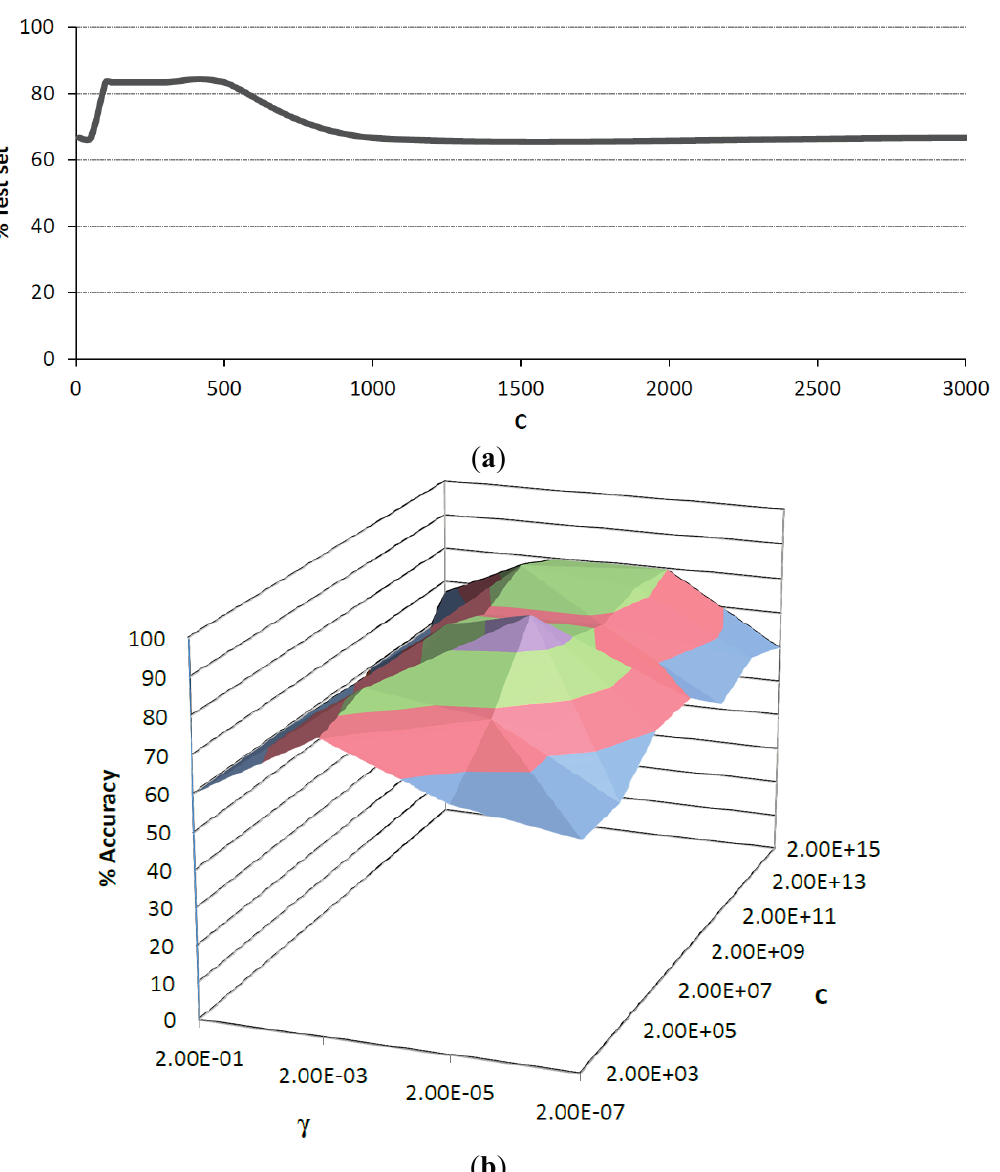
Figure 5. ( a ) Cost parameter evaluation for linear kernel; ( b ) RBF kernel surface response for cost parameter and kernel